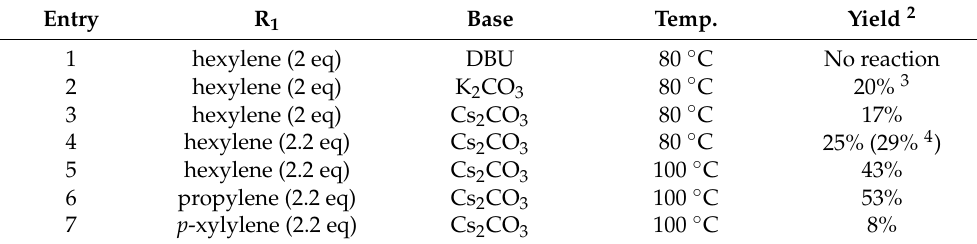
Table 1. Optimizing conditions for the synthesis of CO 2 -immobilized carbonate diol FCD-Ps 1 . Entry